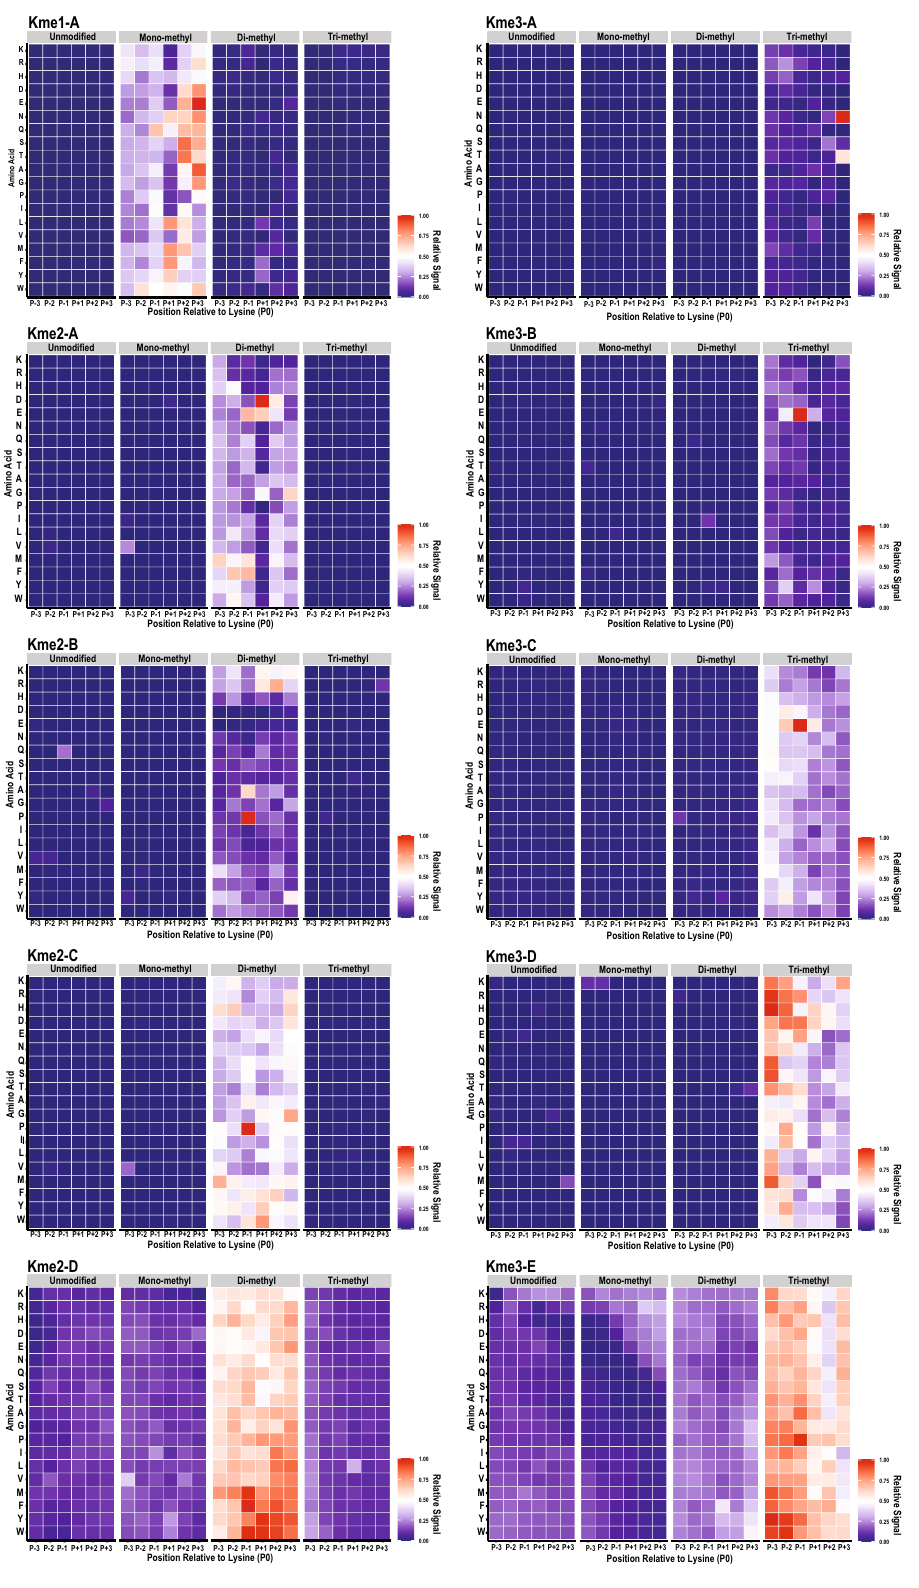
Figure 2. Pan-methyllysine antibodies exhibit sequence bias. Heatmaps depicting average fluorescent signal intensity (n = 3) from a microarray hybridized with the indicated commercially available antibody. Data is globally normalized to the highest signal on the microarray and the color code is proportional to the fluorescent signal, where red (1) indicates more antibody hybridization and blue (0) indicates less antibody hybridization. Rows show the identity of each fixed residue and columns show the position within the sequence relative to the central lysine residue (P0). The modification state of the central lysine residue is indicated by the title above each grouped